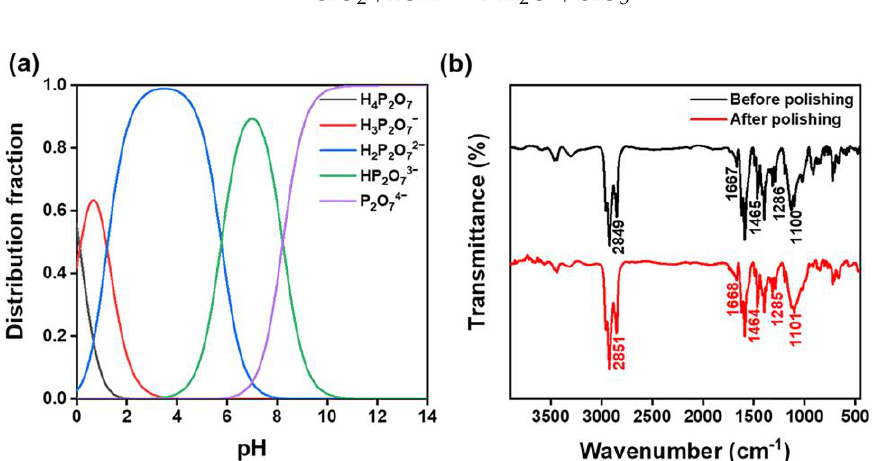
Figure 9. ( a ) Potassium pyrophosphate ion morphology distribution, ( b ) FTIR result of the slurry before and after polishing.